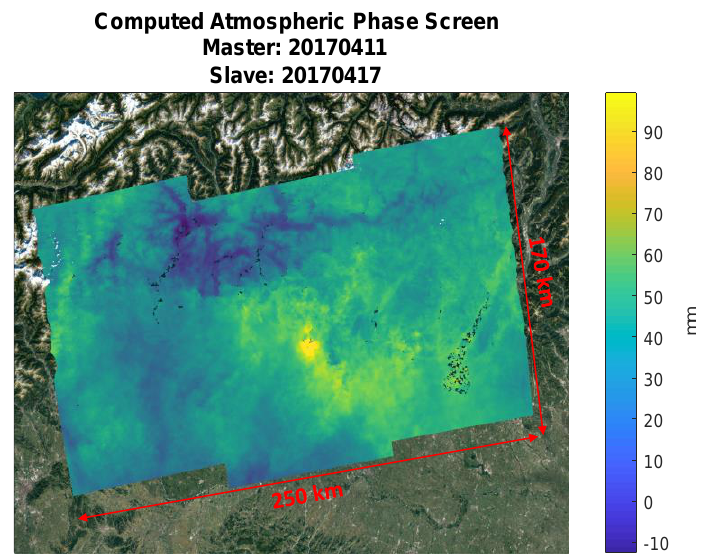
Figure 6. Full swath atmospheric phase screen over Lombardy, Italy.